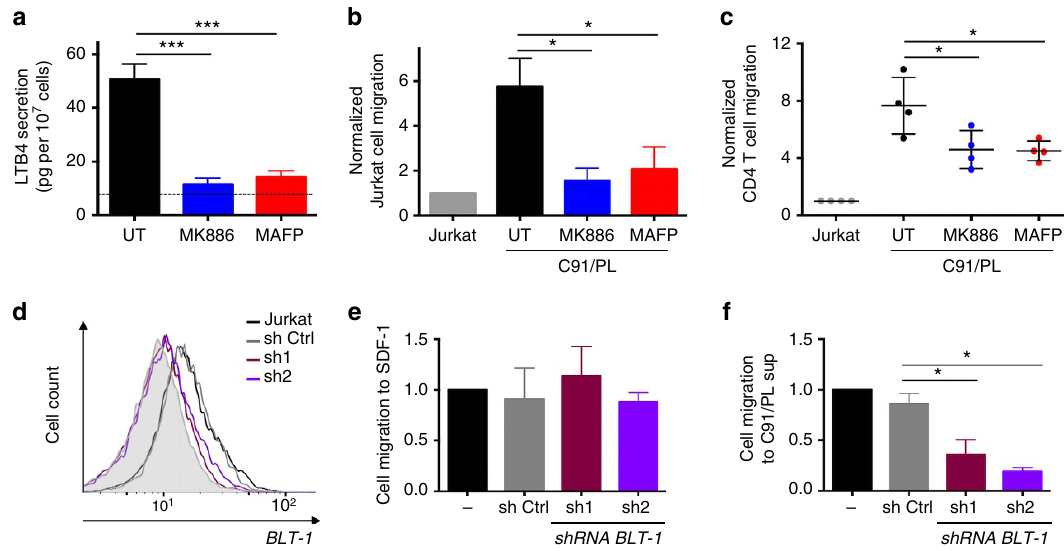
Figure 4 | LTB4 secretion by HTLV-1-infected cells promote lymphocyte chemotaxis. ( a ) Drugs targeting the LTB4 synthesis pathway are efficient on C91/PL cells. C91/PL cells were pretreated with 200nM MK886 or 1 m M MAFP (or left untreated, UT) for 30min. Spontaneous secretion was